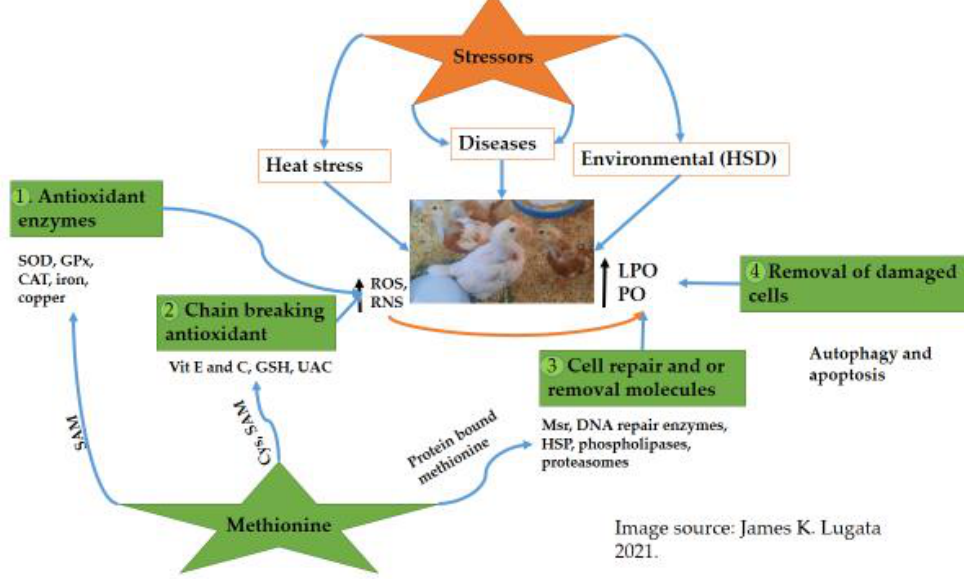
Figure 2. Overview of the effect of stressors, the antioxidant system function, and the influences of Met on poultry’s antioxidant system/status. Adapted from [17,46,49]. The stressors greatly affect poultry production, including heat stress, diseases, environmental, technological, and nutrition, by altering the physiological status due to an increase in the production of Reactive Oxygen Species (ROS) and Reactive Nitrogen species (RNS). The poultry antioxidant defense system plays a great role in detoxifying and preventing ROS’s effect. Four levels of antioxidant defense have been suggested. (1). The first level deals with detoxifying free radicals at the beginning of forming (superoxidase dismutase -SOD, glutathione peroxidase -GPX, catalase -CAT, and chelating metals such as iron and copper). (2). The second level of antioxidant defense deals with scavenging the free radicals (vitamin E and C, glutathione -GSH, and uric acid -UAC). (3). The third level involves cell repairs and removing the damaged molecules; this includes methionine sulfoxide reductase (Msr), heat shock proteins (HSPs), and DNA-repairing enzymes. (4). The 4-fourth level deals with removing damaged cells and preventing the spread of the damage (autophagy and apoptosis). Met, directly and indirectly, influences all the major antioxidant defense levels through the ROS scavenging role of protein Met residues and cysteine (Cys) and SAM, which then influence the activity of the antioxidant enzymes such as SOD and